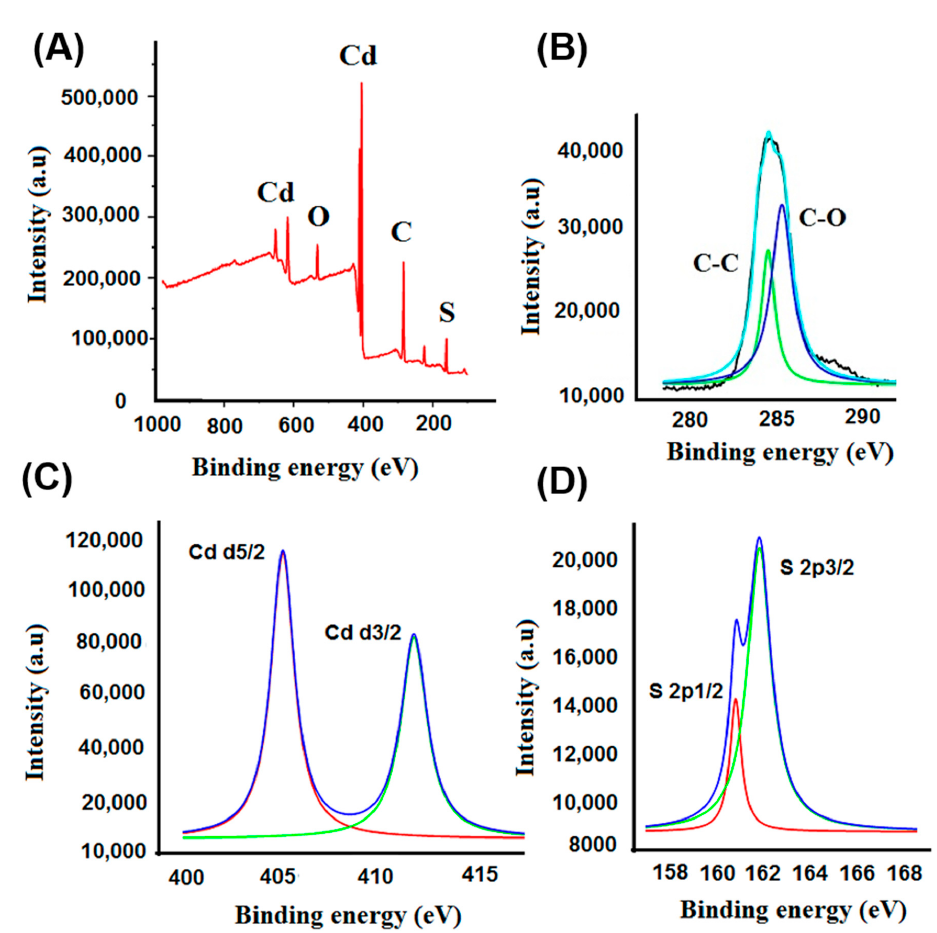
Figure 2. ( A ) XPS survey spectrum of CNFs@CdS; deconvoluted spectra of: ( B ) C 1s; ( C ) Cd 2d; ( D ) S 2p.